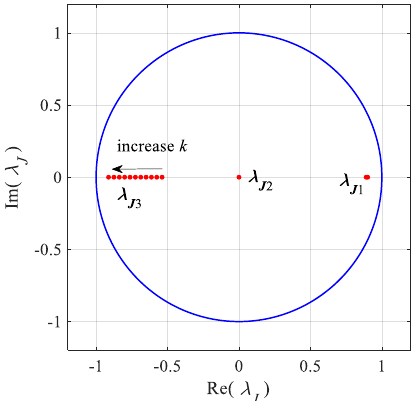
Figure 9. The loci of the Floquet multipliers under the model predictive control.